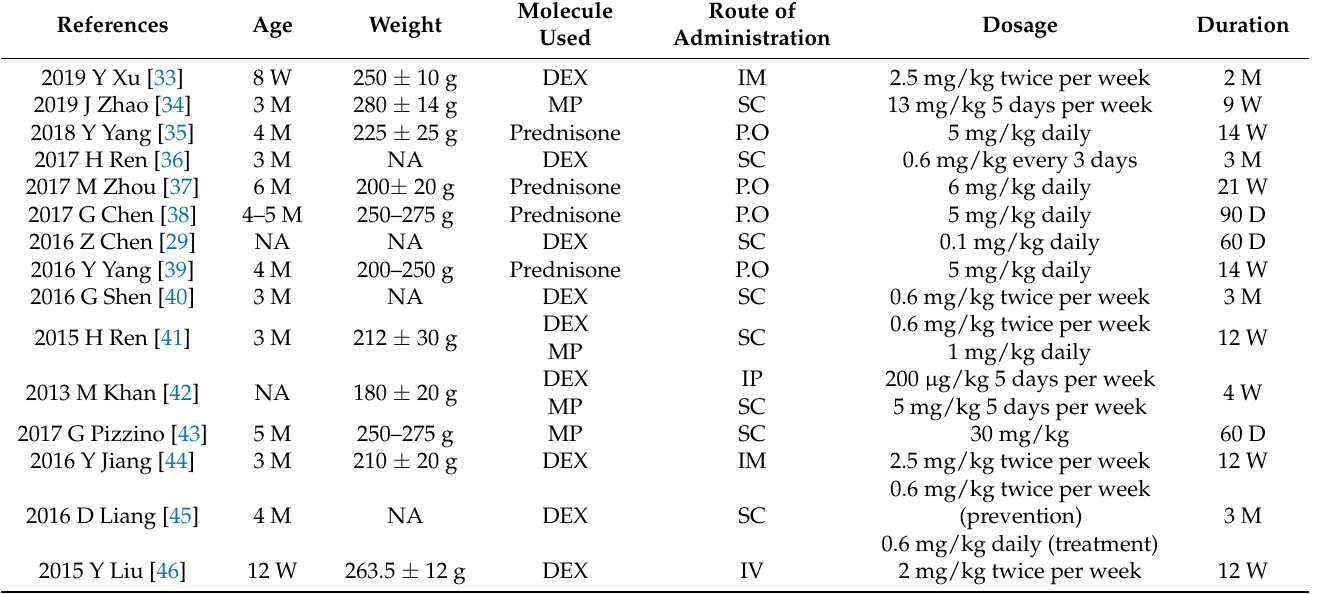
Table 3. Main characteristics of the proposed experimental protocol to induce GIOP in female Spra- gue Dawley. DEX = Dexamethasone, MP = Methylprednisolone, IM = Intramuscular injection, SC = Subcutaneous injection, IV = Intravenous injection, IP = Intraperitoneal injection, P.O = Per. Os, NA = Not Available.